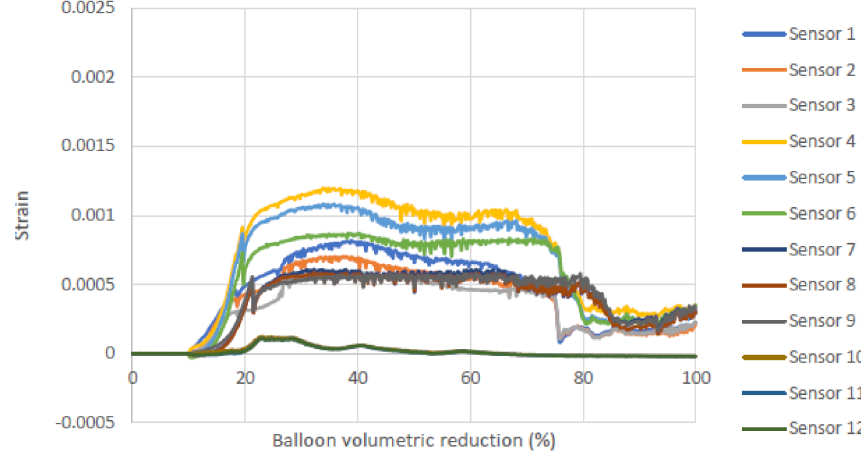
Figure 7. Strain variation for of all FBGs during test 1.